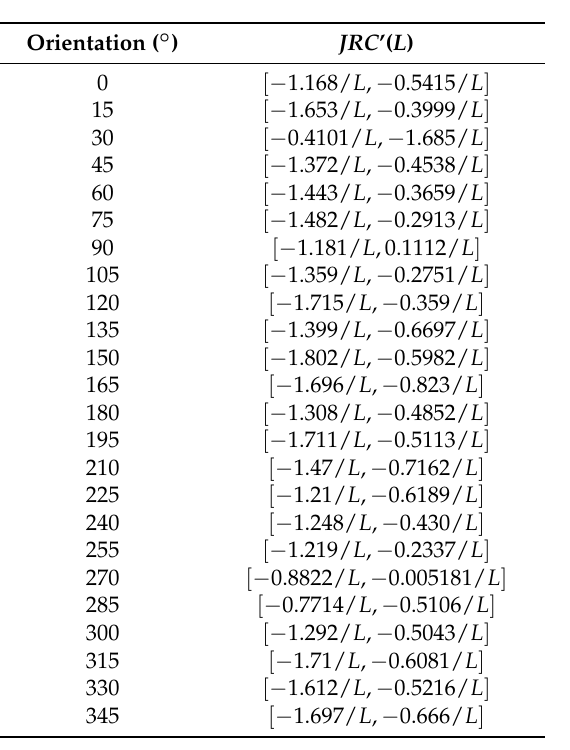
Table 4. NN functions of JRC’ ( L ) for I (cid:15) [0, 0.5] in different